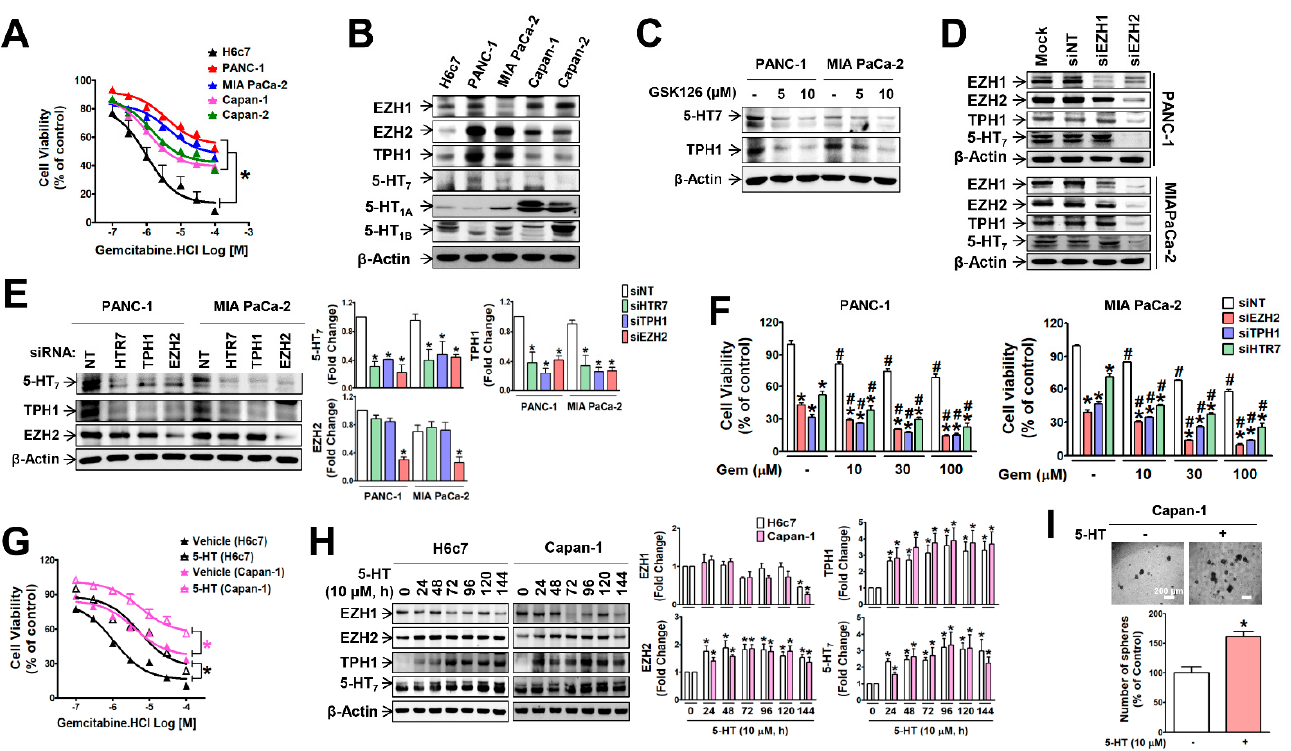
Figure 1. Expression levels of EZH2, TPH1, and 5-HT 7 correlate with gemcitabine resistance in pancreatic cancer cells. ( A ) Sensitivity of PANC-1, MIA PaCa-2, Capan-1, Capan-2, and H6c7 cells to gemcitabine was determined by measuring cell viability after gemcitabine treatment for 48 h. * p < 0.05 compared to H6c7 cells. ( B ) Expression levels of EZH1, EZH2, TPH1, and 5-HT receptors (5-HT 7, 5-HT 1A, 5-HT 1B ) in PANC-1, MIA PaCa-2, Capan-1, Capan-2, and H6c7. ( C ) Treatment of PANC-1 and MIA PaCa-2 cells with GSK-126 for 48 h inhibited 5-HT 7 and TPH1 expressions. ( D ) Down-regulation of 5-HT 7 , TPH1, EZH1 and EZH2 expression by EZH2 siRNA (100 nM) in PANC-1 and MIA PaCa-2 cells. NT represents non-target. ( E , F ) After transfection of PANC-1 and MIA PaCa-2 cells with HTR7, TPH1, or EZH2 siRNA, expression levels of 5-HT 7 , TPH1, and EZH2 ( E ) and gemcitabine sensitivity ( F ) were measured. * p < 0.05 compared to non-target siRNA (siNT)-transfected group. # p < 0.05 compared to the vehicle-treated control. ( G , H ) H6c7 and Capan-1 cells turned out to be gemcitabine-resistant phenotype by treatment with 5-HT (10 μ M) for 96 h ( G ). Time-dependent treatment with 5-HT up-regulated 5-HT 7 , TPH1, and EZH2 expression ( H ). ( I ) Sphere forming ability of Capan-1 cells pretreated with 5-HT (10 μ M) for 96 h was measured. Images of spheres were captured after 14 days of culture in the serum-free medium. Scale bar (white colored) represents 200 μ m at original magnification of 4×. The number of spheroids over 50 μ m in diameter was counted. * p < 0.05, compared to untreated control group. The uncropped Western Blot images can be found in Figure S3.